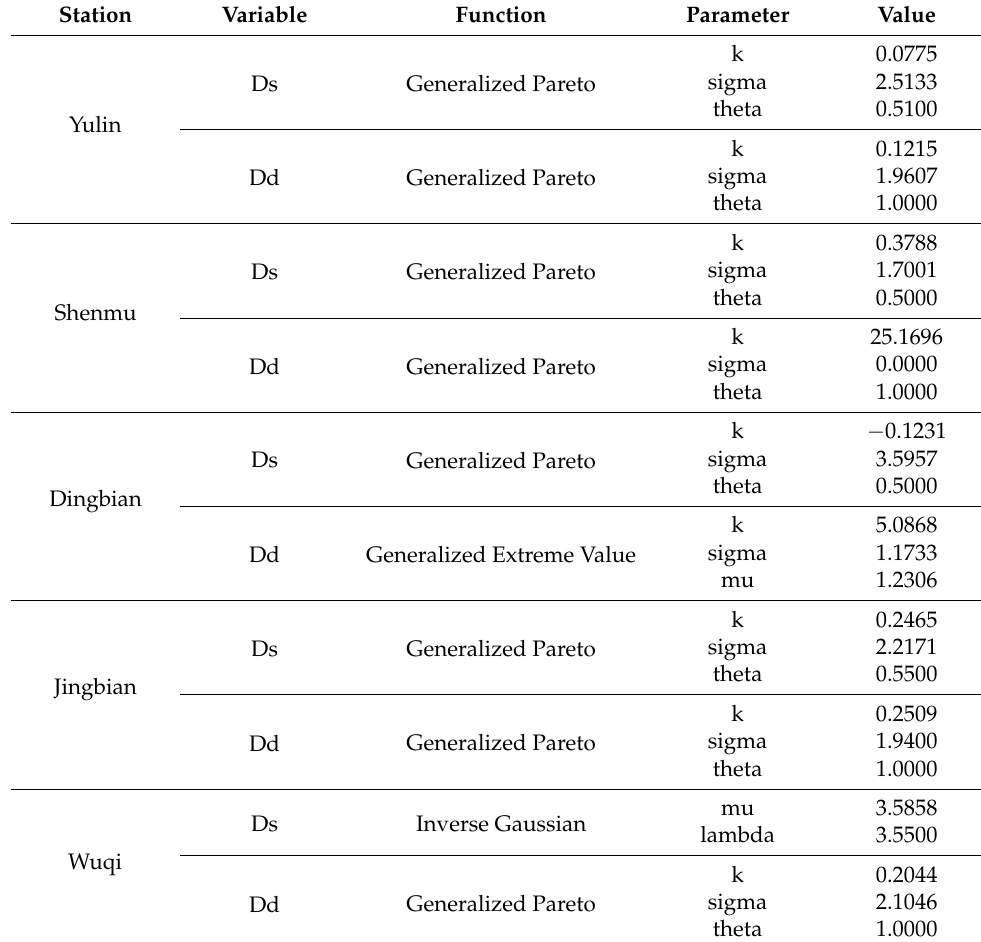
Table 4. The marginal distribution function and parameter values corresponding to drought variables of meteorological stations in Northern